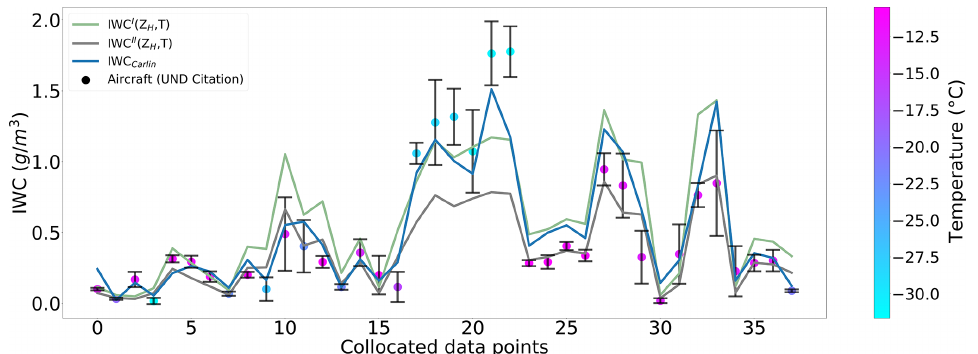
Figure 6. Collocated aircraft in situ data in chronological order (colored dots), the IWC I (Z H ,T ) (green), the IWC II (Z H ,T ) (gray), and the IWC Carlin (blue) of RSVP data (solid lines) for 10 flight missions. Vertical bars have the same meaning as in Fig. 5.